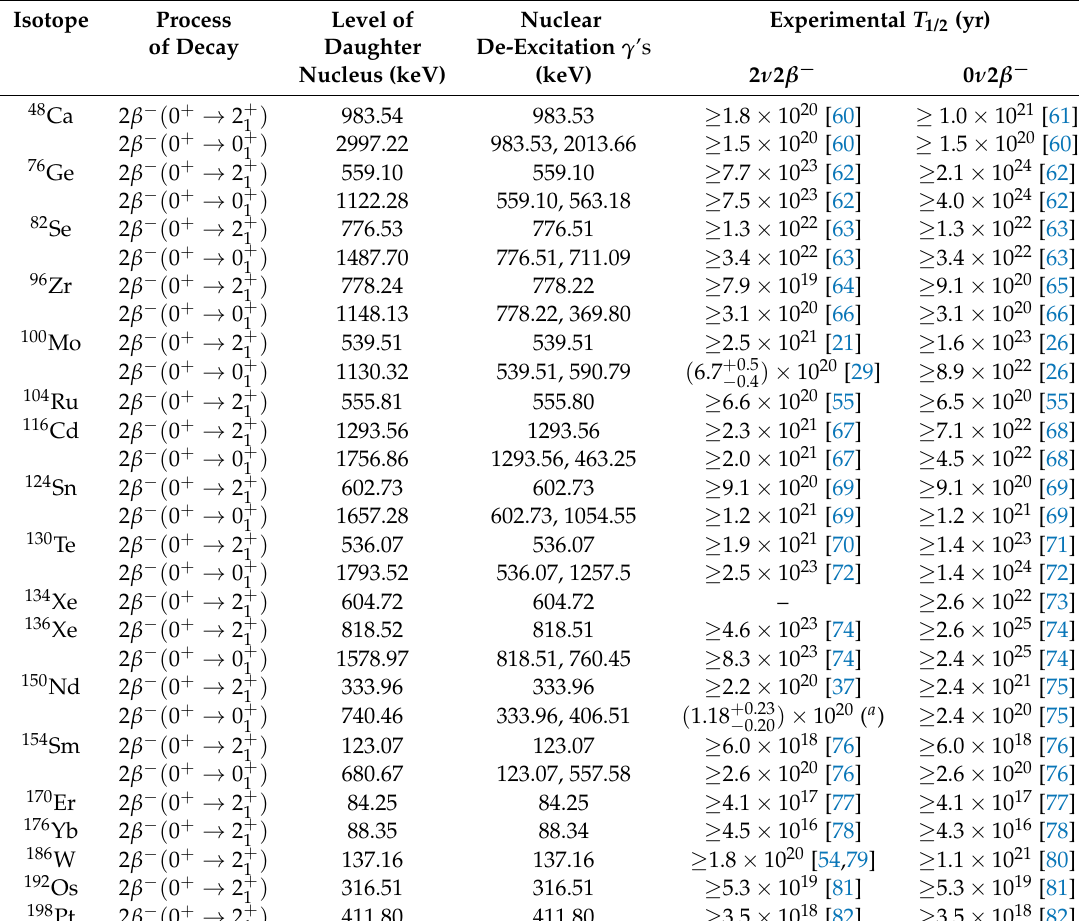
Table 4. Present best experimental results on the half-life, T 1/2 , of the 2 β − decay (2 ν and 0 ν ) to the excited levels of daughter nuclei (limits are at 90% C.L.) for some of the isotopes most considered in the field. Only the transitions to the first 2 + and 0 + excited levels of the daughter nucleus, if energetically allowed, are considered. See